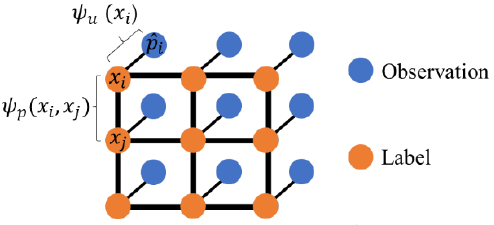
Figure 3. The unary and pairwise term of the CRF